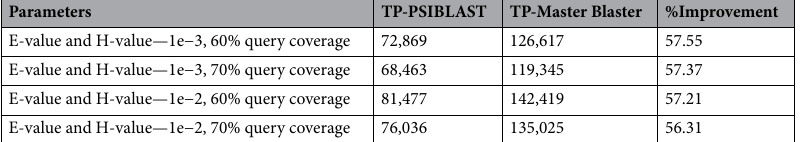
Table 3. Comparative performance of PSI-BLAST and Master Blaster. Number of true positives (TP) reported by PSI-BLAST and Master Blaster and %Improvement.